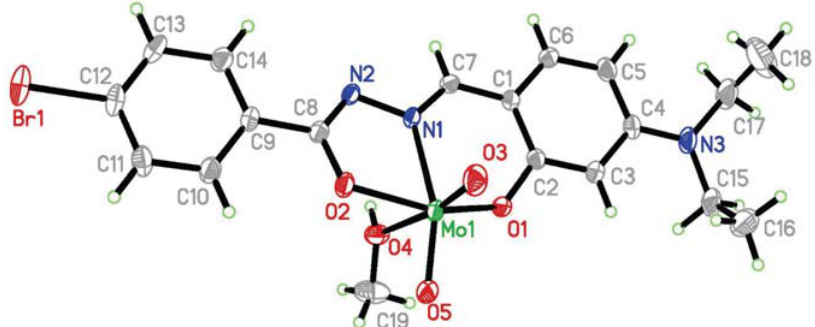
Figure 1. Molecular structure of the complex at 30% probability displacement.